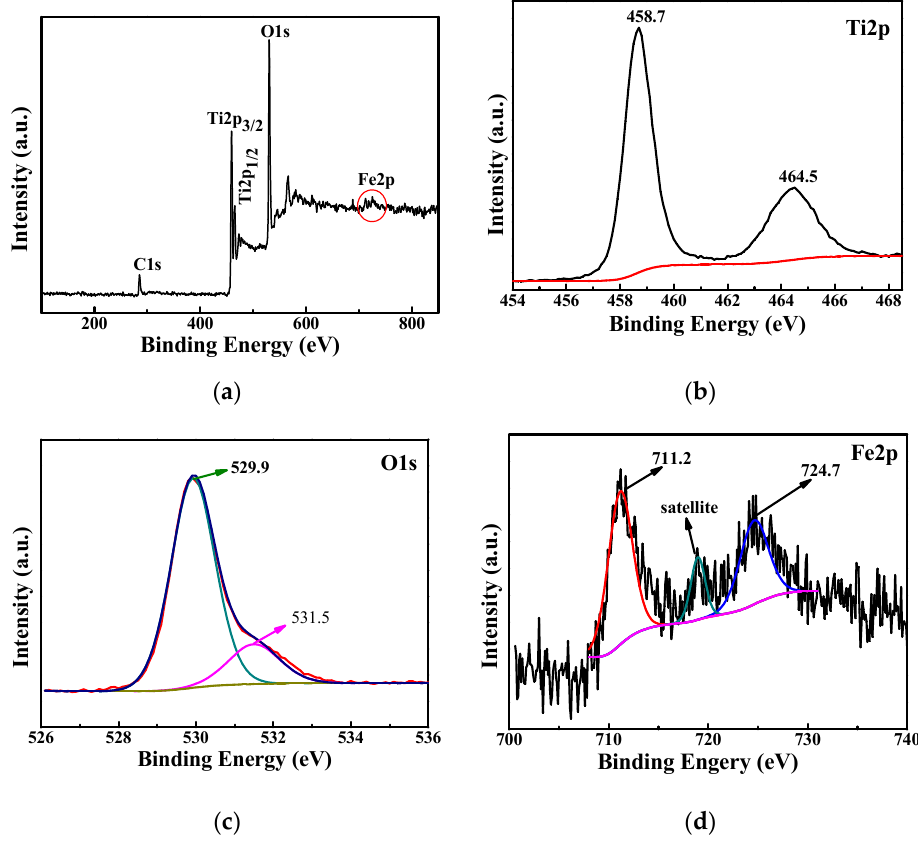
Figure 6. XPS spectra of 5%Fe-TiO 2 ( a ) and the high-resolution spectra of Ti2p ( b ), O1s ( c ) and Fe2p ( d ).